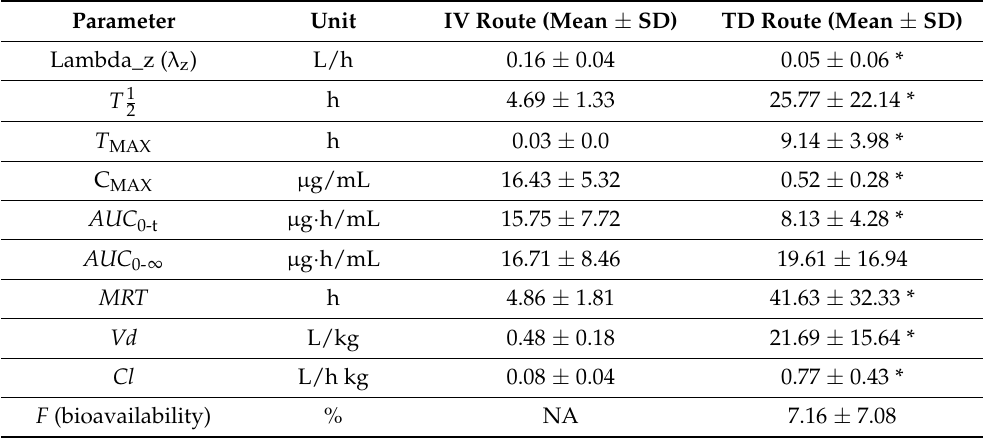
Table 1. Pharmacokinetic parameters were calculated for ketoprofen after a single IV bolus (1 mg/kg) and after a single topical application (10 mg/kg) of TDK formulation in six healthy